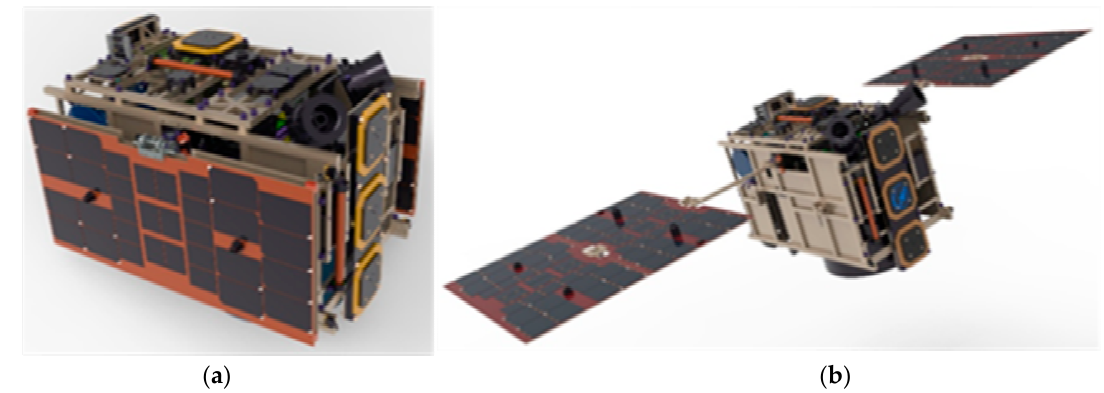
Figure 1. The MF satellite model. ( a ) Launch state; ( b ) On-orbit state.